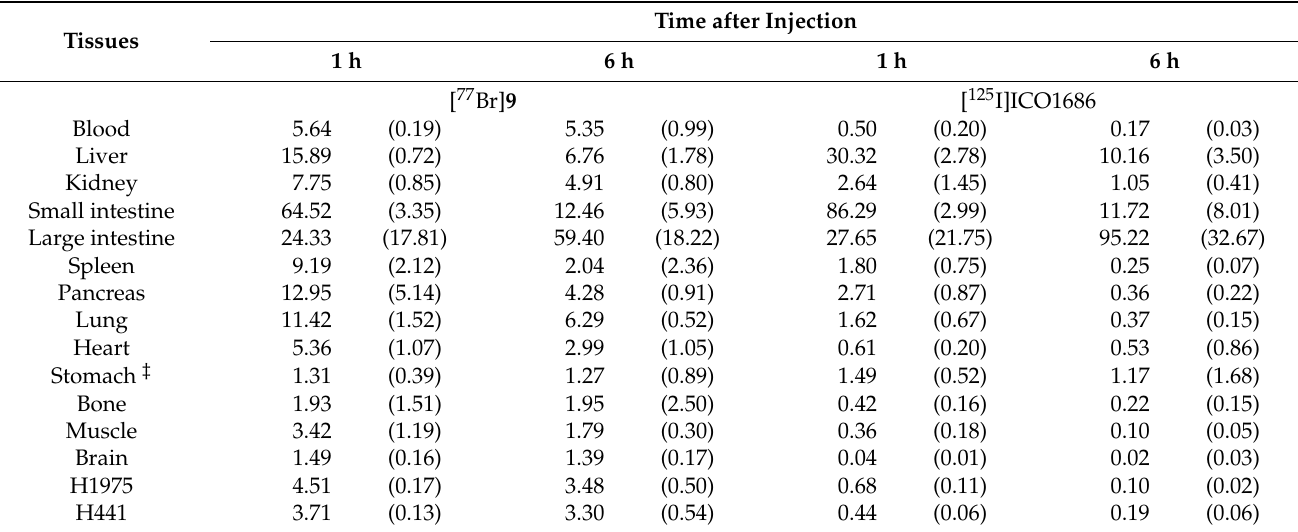
Table 3. Biodistribution of double tracers [ 77 Br] 9 and [ 125 I]ICO1686 at 1 and 6 h after i.v. injection in tumor-bearing